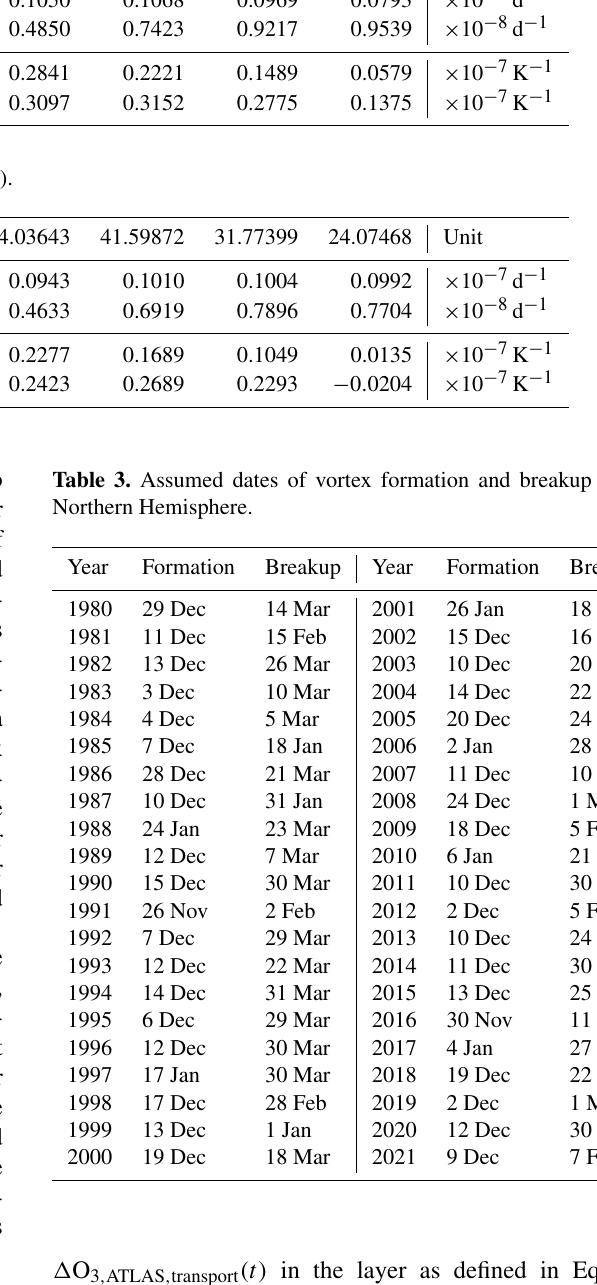
(cid:49) O 3 , ATLAS , transport (t) in the layer as defined in Eq. (2). For the fit, we concatenate the time series of all individual years between the start dates and the end dates (Table 3) to a single time series. (cid:49)T ERA5 (t) is the corresponding change of vortex-averaged temperature per day obtained from ECMWF ERA5 data (not to be confused with (cid:49)T GCM (t) ), (t) is the change of the vortex-averaged radiative and (cid:49)T (cid:48) R equilibrium temperature per day (not to be confused with (cid:49)T R (t) from Eq. (1), which is the change within the